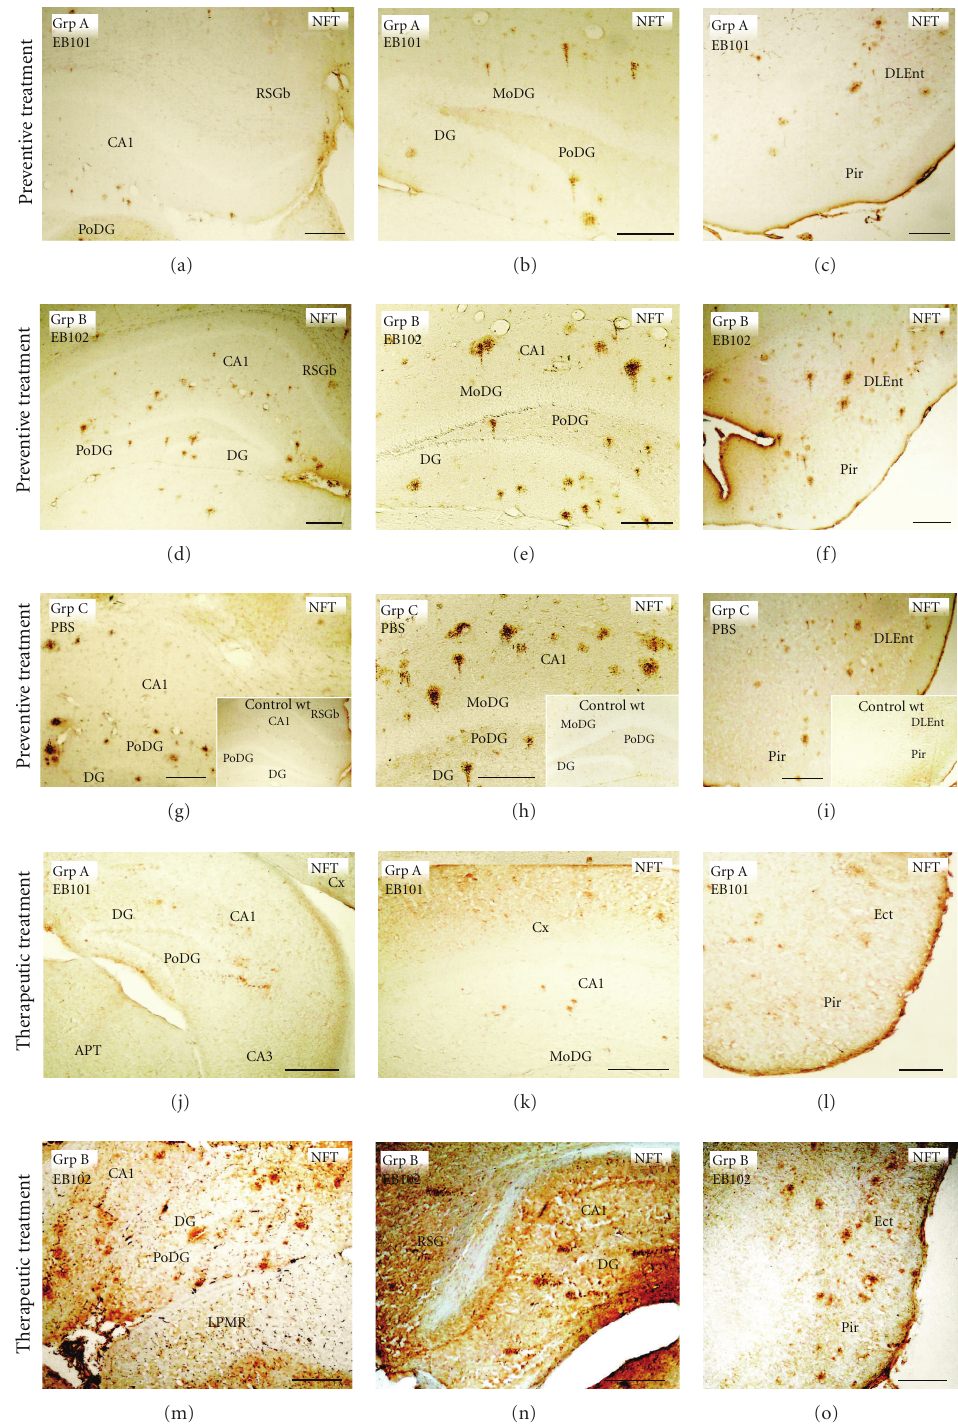
Figure 3: E ff ect of EB101 vaccine on neurofibrillary tangle-like structures in the brains of B6C3F1/J mice. Comparative photomicrographs of neurofibrillary tangle-like structure immunoreactivity taken in the hippocampus ((a), (b), (d), (e), (g), (h), (j), (k), (m), (n)) and cortical ((c), (f), (i), (l), (o)) brain regions in the preventive treatment group, ((a)–(i)) and therapeutic treatment group, ((j)–(o)). Preventive Treatment : Transverse brain sections of 11-month-old mice show almost complete prevention of neurofibrillary tangle-like structure (NFTs) formation after EB101 vaccine immunization in the hippocampal subregion CA1 (a), dentate gyrus (b), and entorhinal cortex (c) contrasting with the same regions of EB102-immunized mice ((d)–(f)) and PBS ((g)–(i)). Immunoreactive NFTs are absent in the brain sections of wild- type mice (inserts in (g)–(i)). Therapeutic Treatment : Transverse brain sections of 18-month-old mice show almost complete reduction of NFTs after EB101 vaccine immunization in the dentate gyrus (j), hippocampal subregion CA1 (k), and entorhinal cortex (l), compared with the same regions of EB102-immunized mice ((m)–(o)). Scale bar: 100 μ